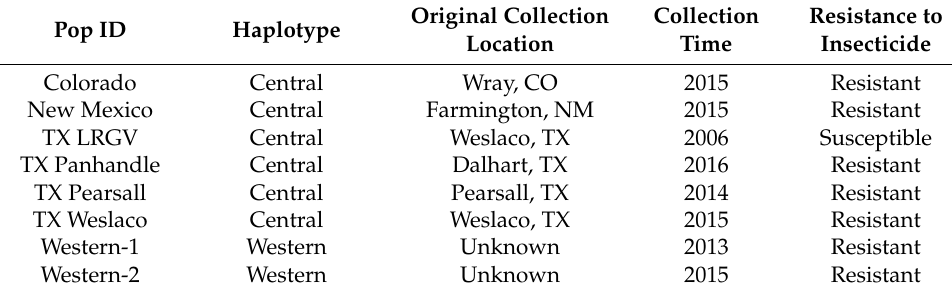
Table 1. List of potato psyllid colonies included in this study. Pop